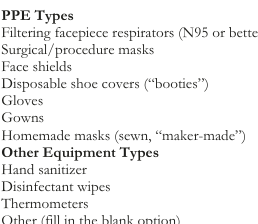
Fig. 4 PPE and equipment types. Recipients were able to request multiple types of PPE.